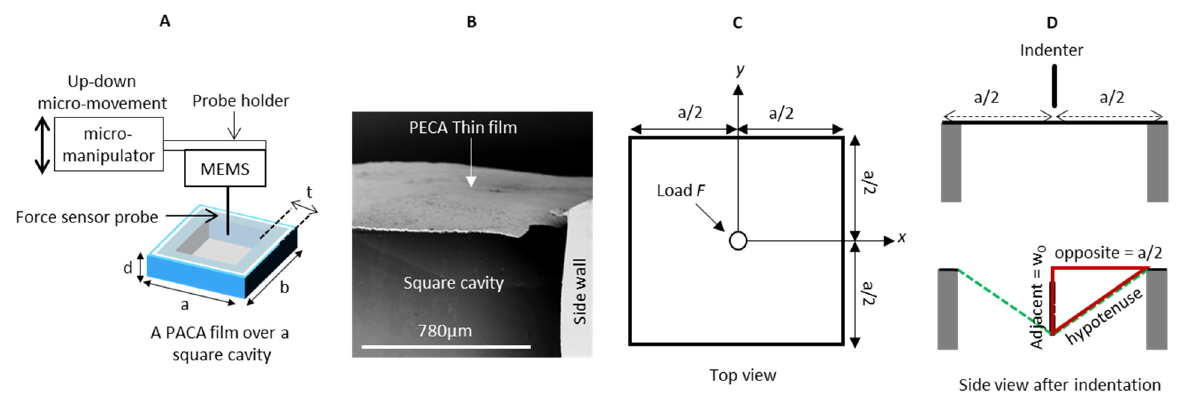
Figure 1. Test principle. ( A ) A schematic illustration of the microindentation setup. A square-shaped polymer frame (3 mm by 3 mm) covered with the PACA membrane is subjected to indentation with a MEMS device. ( B ) SEM image of an experimentally obtained PECA thin film over the square skele-ton. ( C , D ) Geometry model of the thin film from top and side view. ( D ) Upper panel: before inden-tation, lower panel: after indentation.